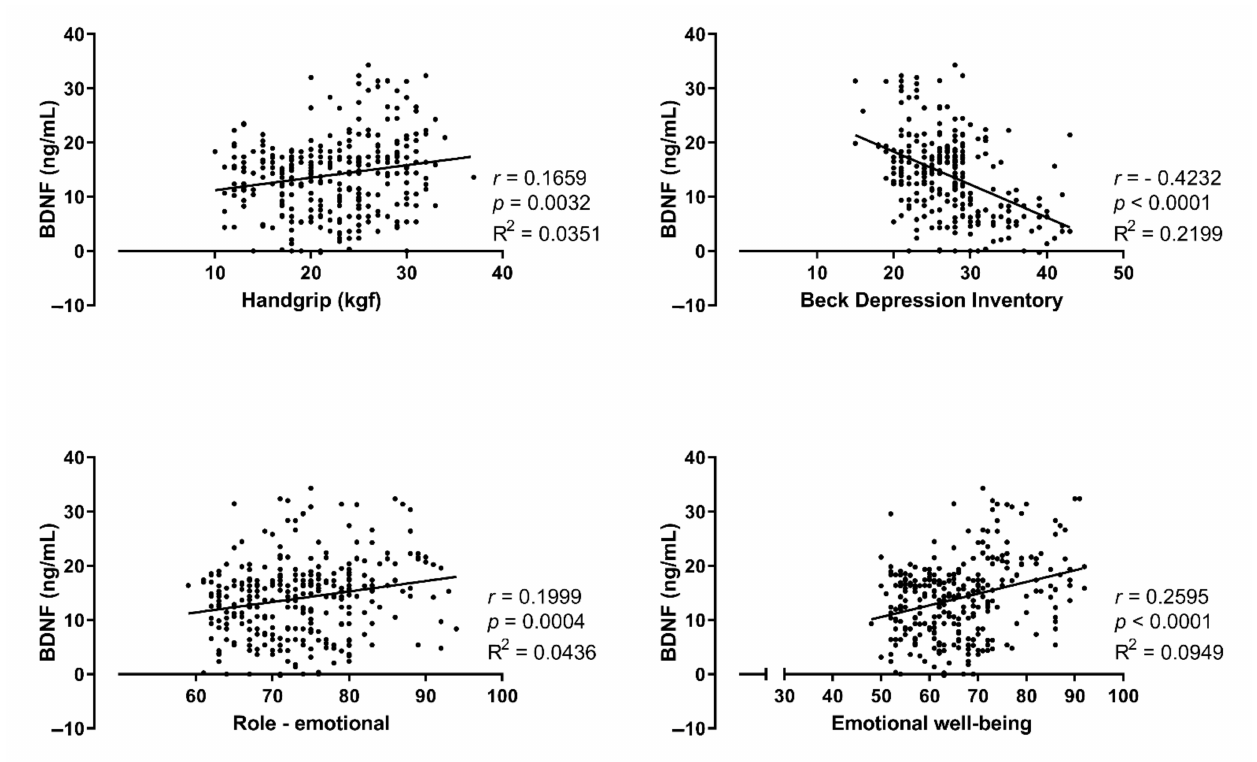
Figure 2. Spearman’s correlation with pooled groups ( n = 157). Correlations between BDNF (ng/mL), handgrip (kgf), Beck depression inventory, and both dimension the emotional role and emotional